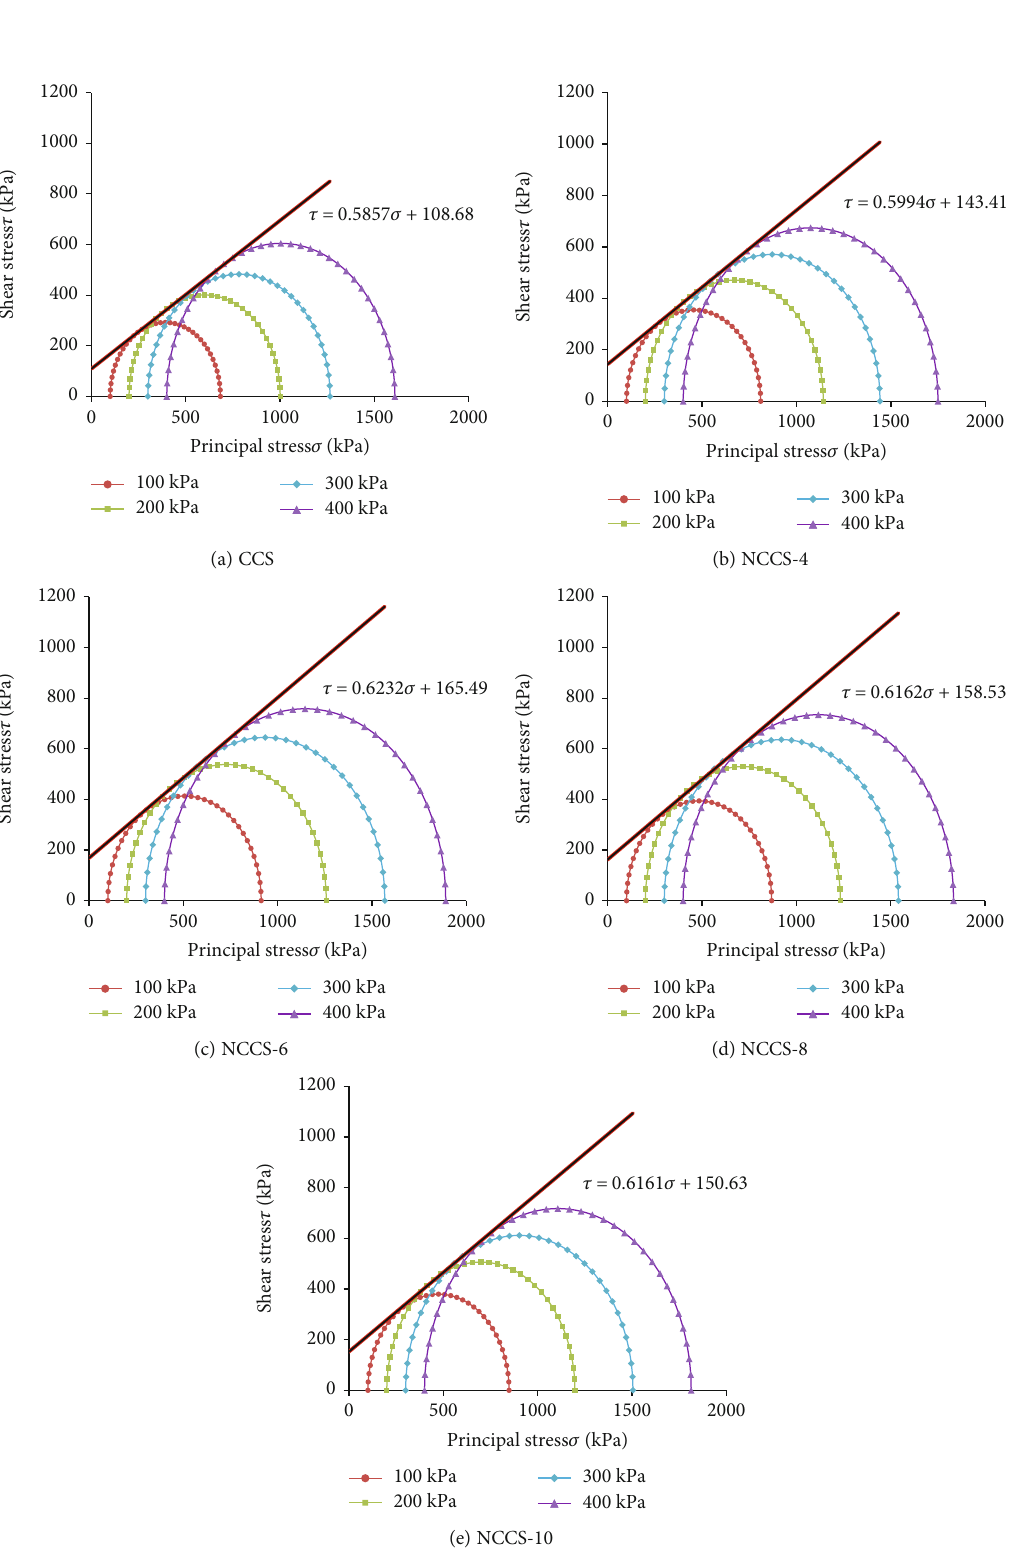
Figure 4: Strength envelopes of CCS and